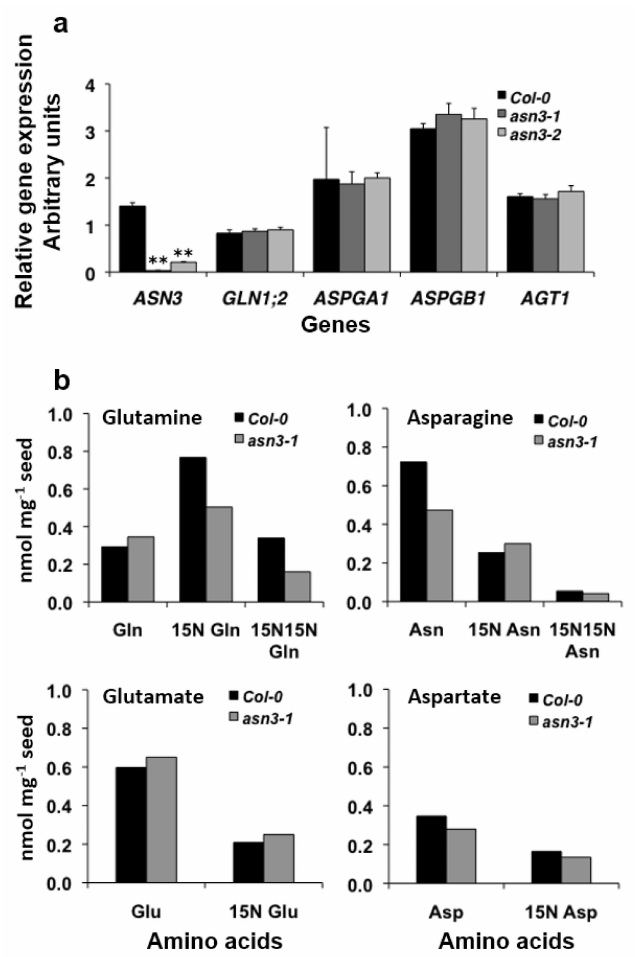
Figure 5. Comparison of ( a ) mRNA levels of ASN3 , GLN1;2, ASPGA1, ASPGB1 and AGT1 and ( b ) 15 N labeling of glutamine, glutamate, asparagine and aspartate in Col-0 and asn3-1 seeds imbibed for 24 h. A qRT-PCR analysis was carried out to estimate mRNA levels of ASN3 (At5g10240) coding for asparagine synthetase, GLN1;2 (At1g66200) for cytosolic GS1, ASPGA1 (At5g08100) and ASPGB1 (At3g16150) for asparaginase and AGT1 (At2g13360) for asparagine aminotransferase. Transcript levels, relative to Actin 2 (At3g18780) as a reference gene, are expressed as the mean ˘ SE of three biological replicates. The 15 N labeling analysis was carried out on three sets, each comprising more than 150 seeds using the same initial weight per genotype to determine single labeling ( 15 N glutamine, 15 N glutamate, 15 N asparagine, 15 N aspartate) and double labeling ( 15 N 15 N glutamine, 15 N 15 N asparagine). Asterisks indicate significant differences between wild-type and transgenic lines with Student’s t test p -values ** p <